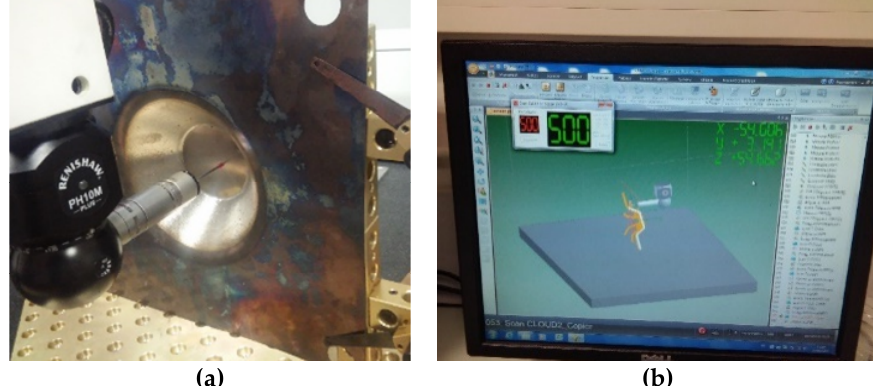
Figure 5. Scan truncated cone ( a ) with three-dimensional measuring machine (MMT) ( b ).